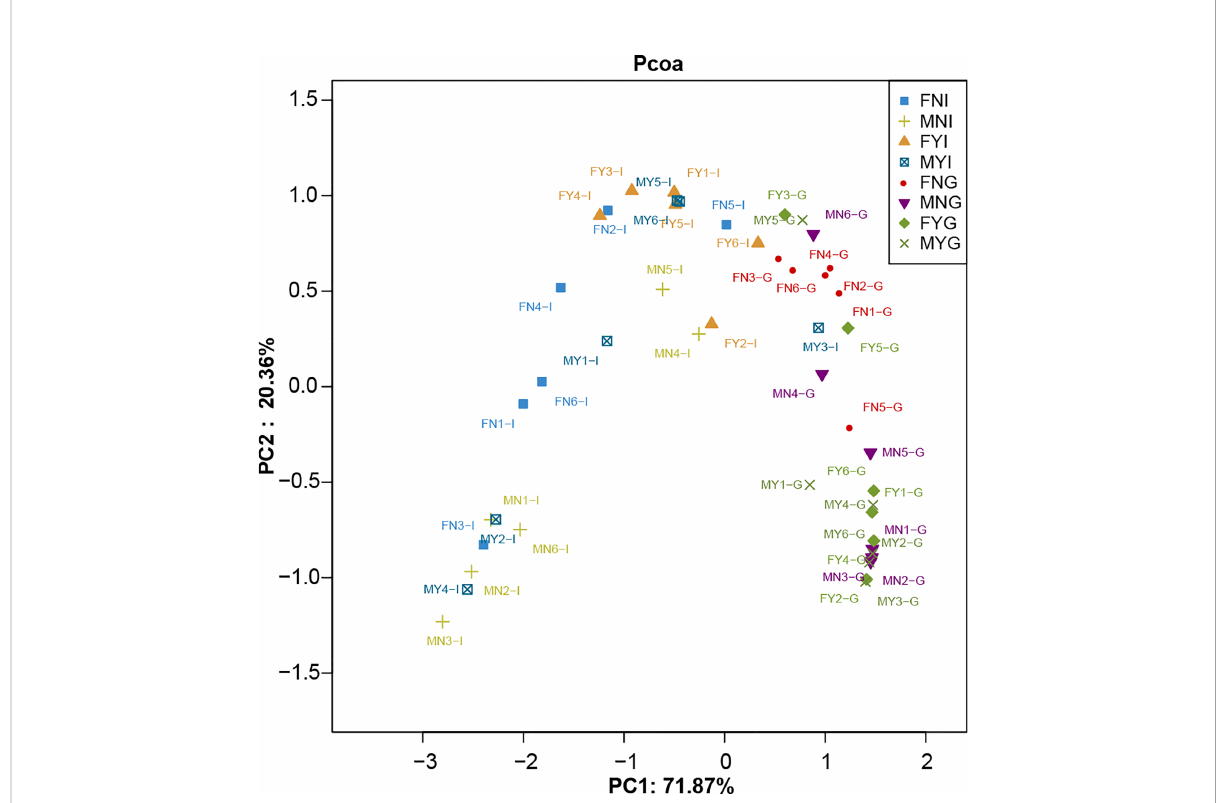
FIGURE 5 Principal coordinate analysis (PCoA) of the intestine and gill microbial samples of medium-form populations of Sthenoteuthis oualaniensis based on weighted UniFrac